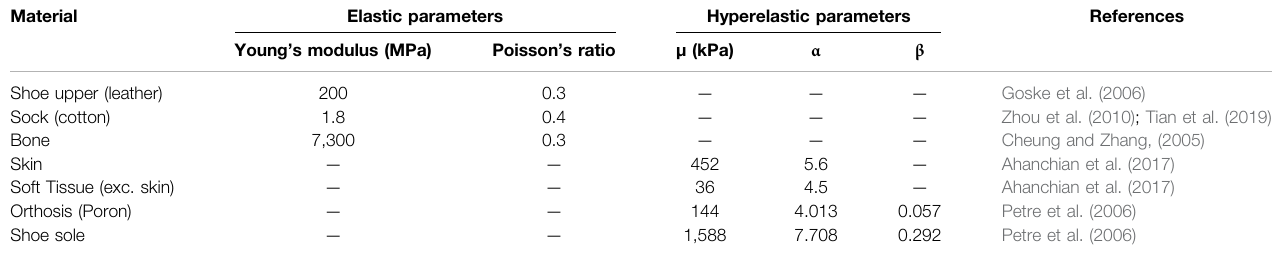
TABLE 1 | Material Properties for linear elastic shoe sides, sock, bone and hyperelastic soft tissue, orthosis, shoe sole.